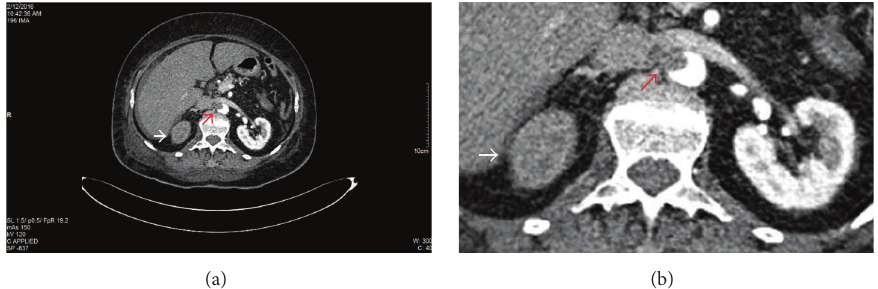
Figure 1: (a) Contrast-enhanced CT scan. Right renal artery occlusion with endoluminal aortic thrombus. The red arrow marks the endoluminal aortic thrombus at the emergence of the right renal artery. The white arrow shows the absence of nephrogram of the right kidney suggestive of renal infarction. (b) An enlarged image of (a) in which the red arrow marks the endoluminal aortic thrombus and the white arrow shows the right kidney with the absence of the nephrogram.